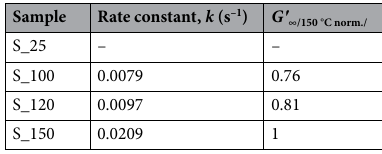
Table 3. Kinetics parameters.